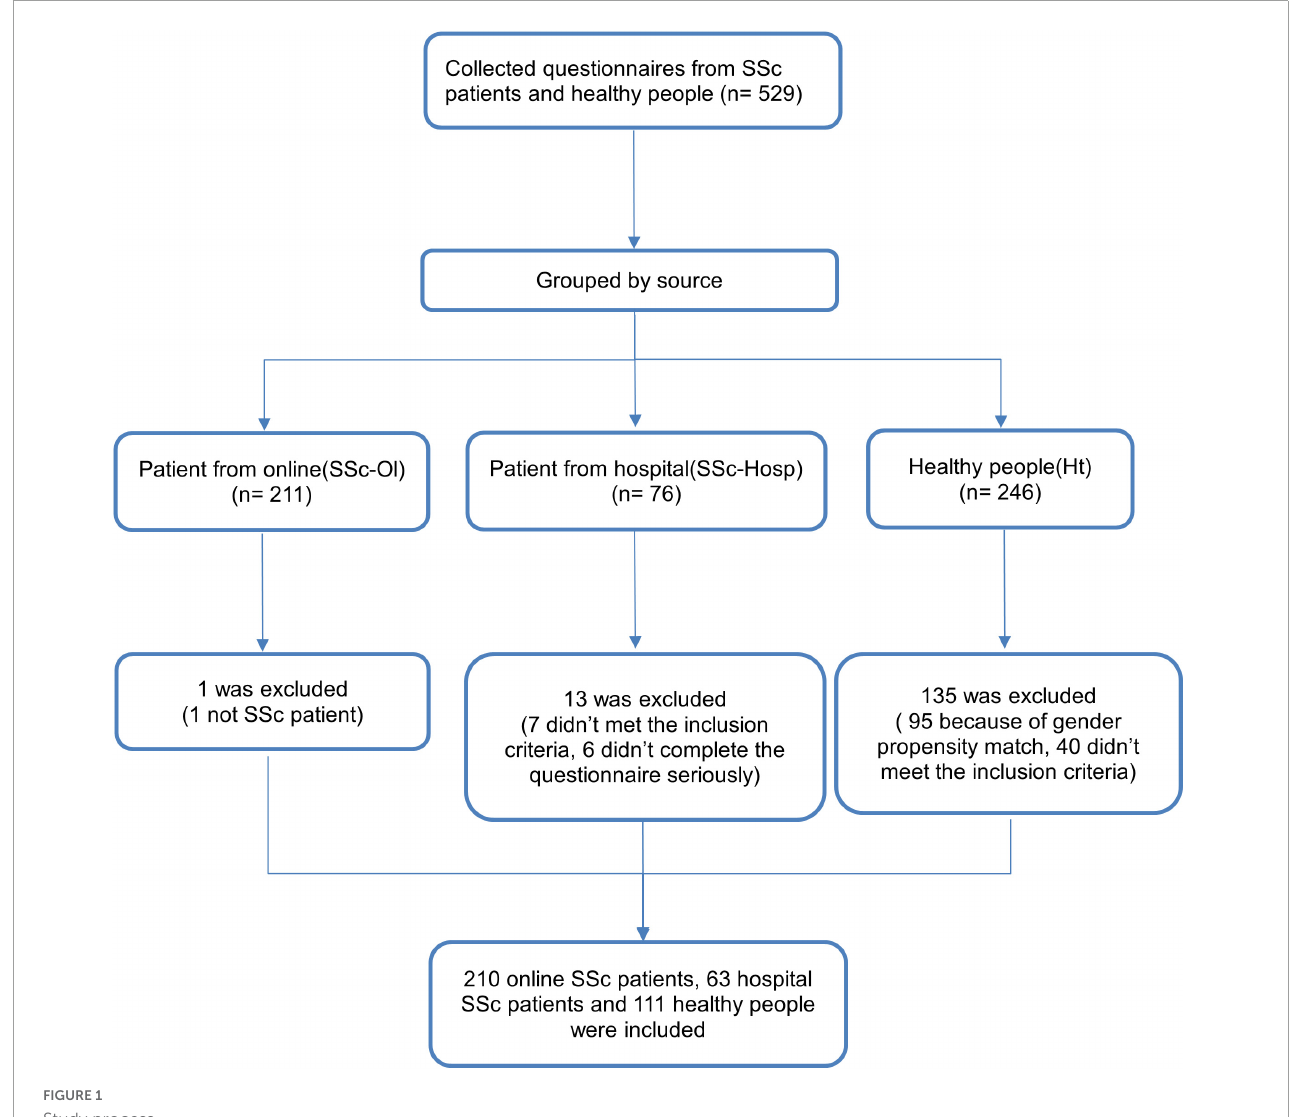
FIGURE1 Study process.